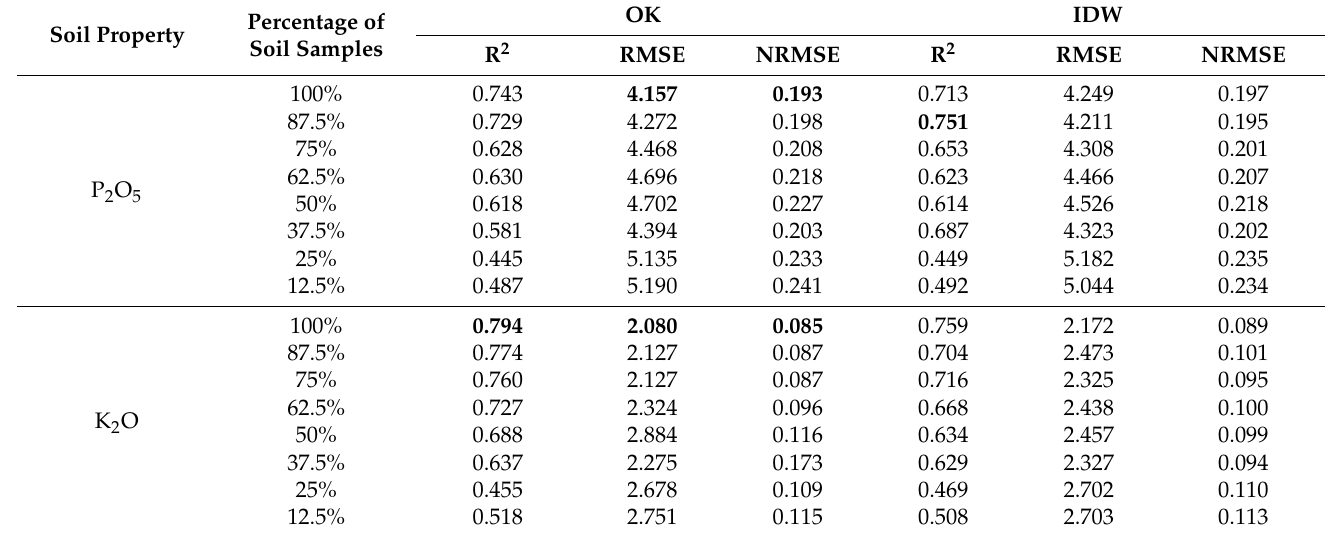
Table 3. Interpolation accuracy results for soil subsets using OK and IDW interpolation methods. Soil